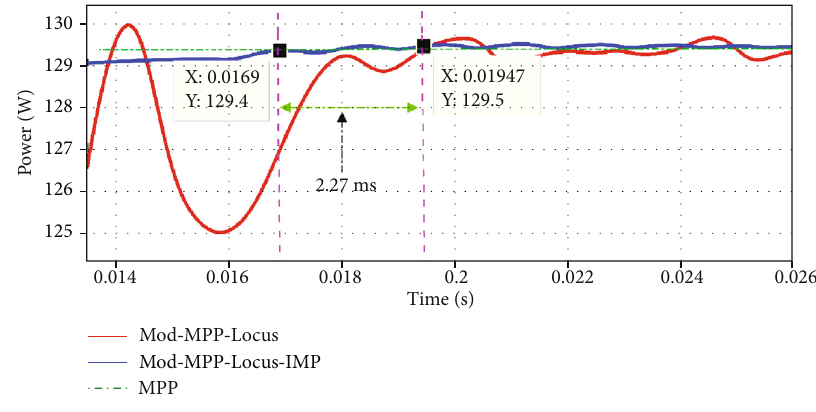
Figure 27: The response speed comparison for Figure 25(c).